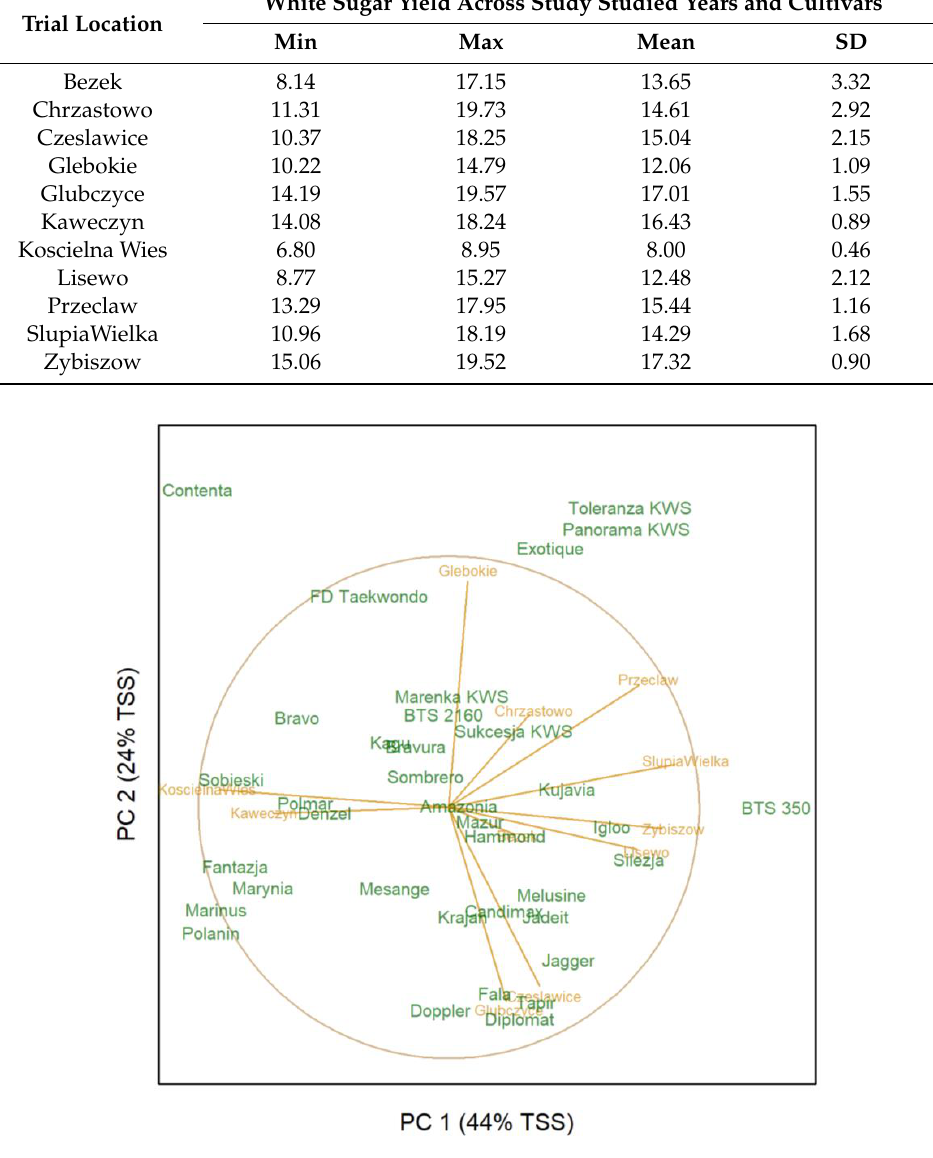
Figure 1. The GGE biplot based on adjusted means of the cultivar × trial location combinations for white sugar yield; PC = principal component; TSS = total sum of square.